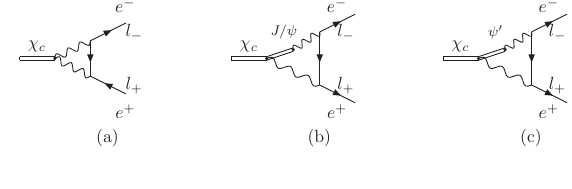
Figure 2. Diagrams for decay widths Γ ( χ 0 , 1 , 2